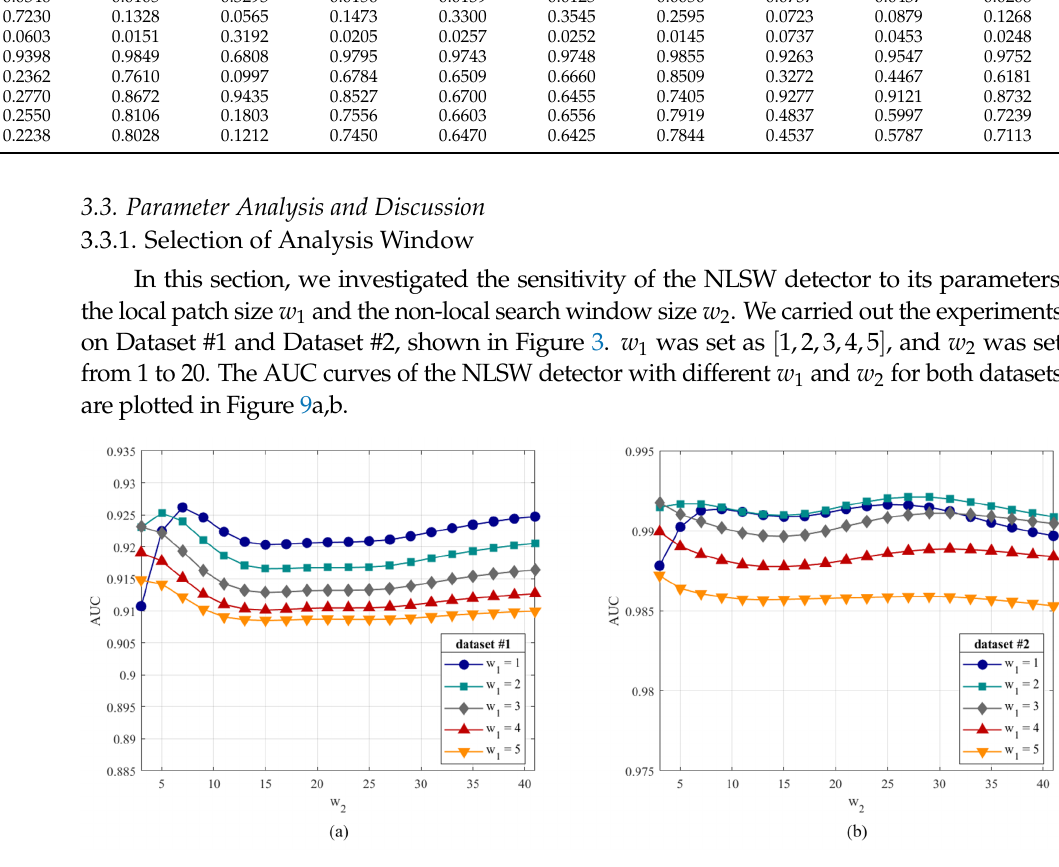
Figure 9. AUC curves with different sizes of patch ( w 1 ) and non-local search windows ( w 2 ) : ( a ) Dataset #1. ( b ) Dataset